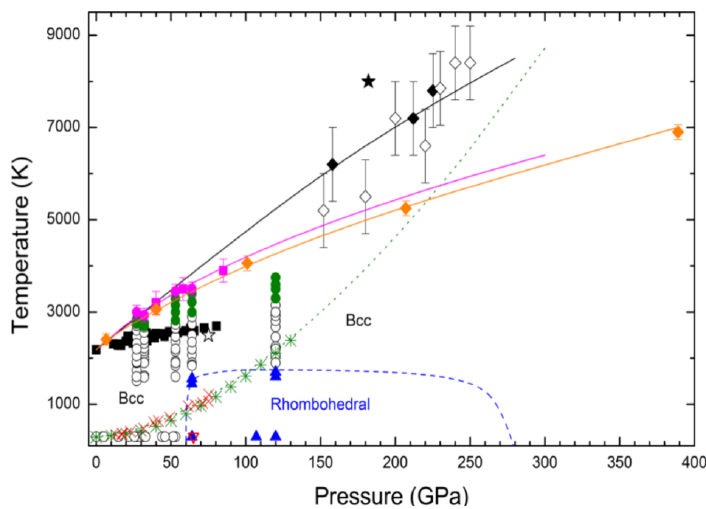
Figure 6. Pressure–temperature phase diagram of vanadium. (By the courtesy of Ref. [62]). Most recently, Zhang et al. [69] also determined the phase stability of vanadium at 0–4400 K and 20–100 GPa by using synchrotron XRD independently. The results showed that BCC vanadium stabilized below 44 GPa at room temperature. With increasing the pressure above 52 GPa, a BCC → RH phase transition occurs, which is consistent with the observations of Errandonea et al. using NaCl as the pressure medium at 53 GPa [62]. Moreover, Zhang et al.’s experimental results showed that the RH vanadium stabilized between 50 and 100 GPa at room temperature [69]. At the pressure of 52 GPa, the RH